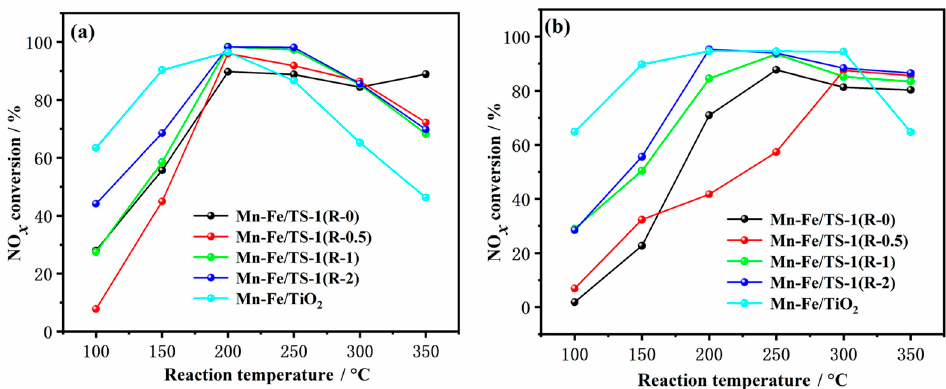
Figure 8. NO x conversion as a function of reaction temperatures over the Mn–Fe/TS-1(R-0), Mn– Fe/TS-1(R-0.5), Mn–Fe/TS-1(R-1), Mn–Fe/TS-1(R-2), and Mn–Fe/TiO 2 in the absence ( a ) and presence of H 2 O and SO 2 ( b ). Reaction conditions: 500 ppm NO, 500 ppm NH 3 , 5% O 2 , 100 ppm SO 2 (when used), 5 vol % H 2 O (when used), and balanced with N 2 ; the total flow rate was 100 mL/min.